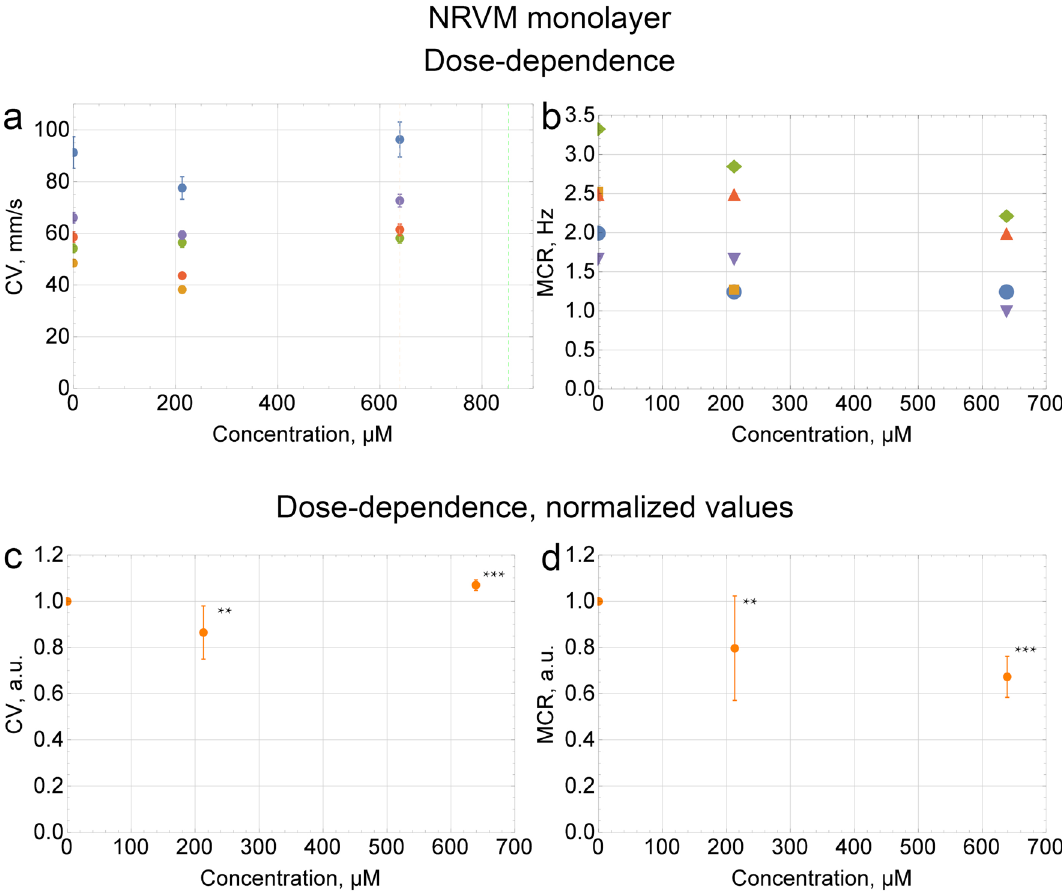
Figure 5. The CP dose-dependences of CV and MCR in the NRVM monolayer. The CV was measured at a frequency of 1 Hz. For the MCR measurements, the frequency was increased from 1 to 5 Hz in increments of ≤ 0.5 Hz. Dashed lines indicate the moments when normal propagation stopped. ( a ) Error bars on each individual point represent the equipment error for each measurement of CV. ( c , d ) Data of each run was normalized to the control value. Summary data is presented as mean ± SD (n = 5); **p < 0.01, ***p < 0.001 vs.